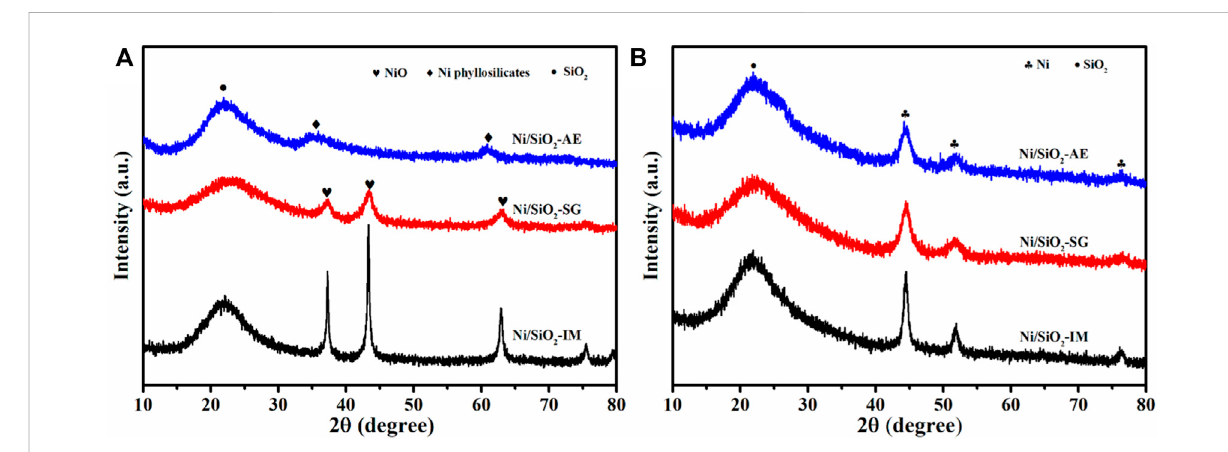
FIGURE 2 XRD patterns of (A) calcined and (B) reduced Ni/SiO 2 catalysts prepared by different